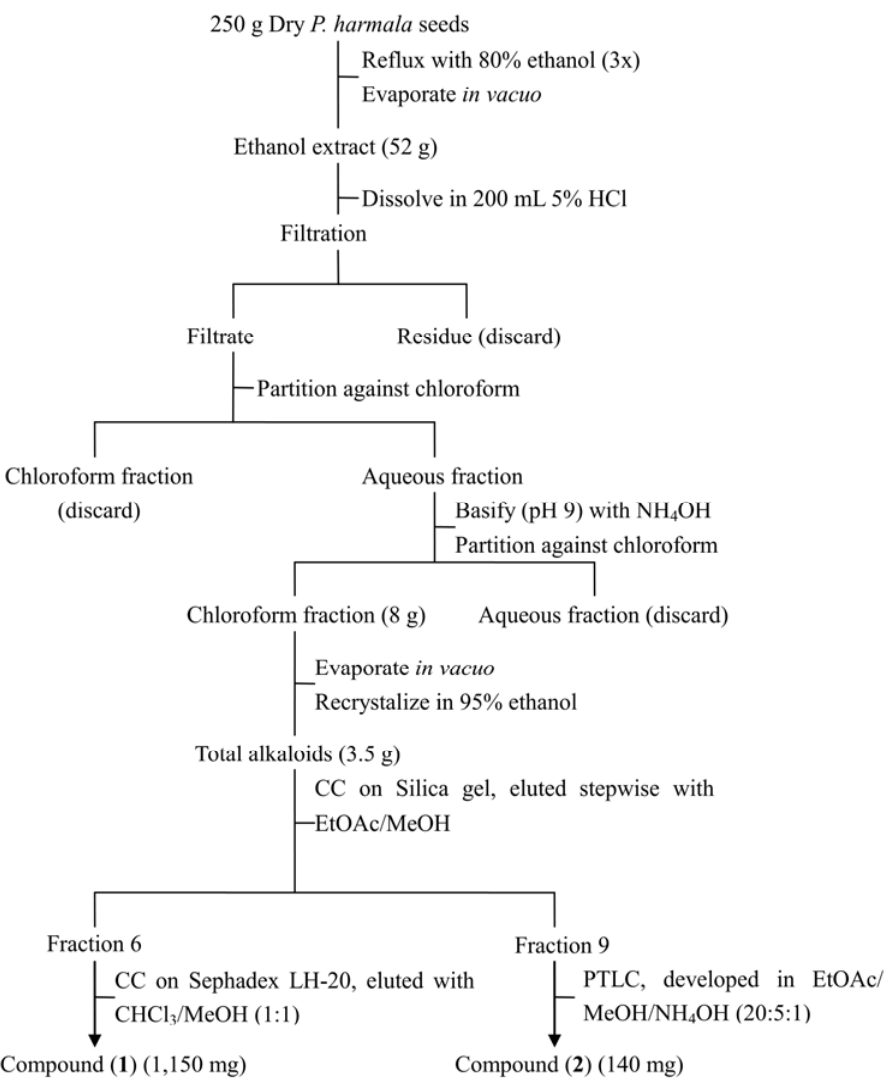
Figure 2. Protocol for isolation of harmaline and